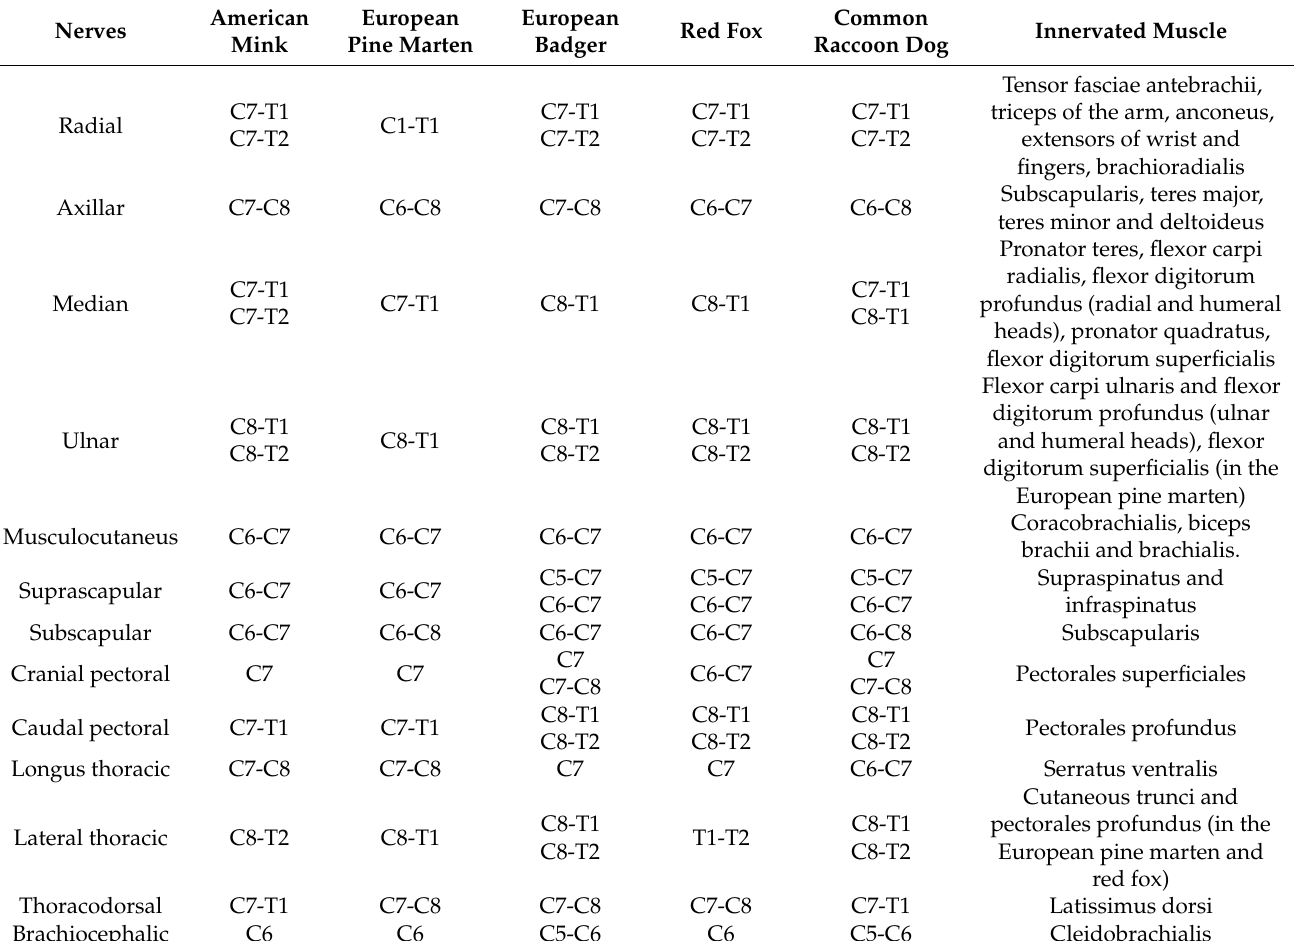
Table 2. Origin of brachial plexus nerves in the species studied and their innervation